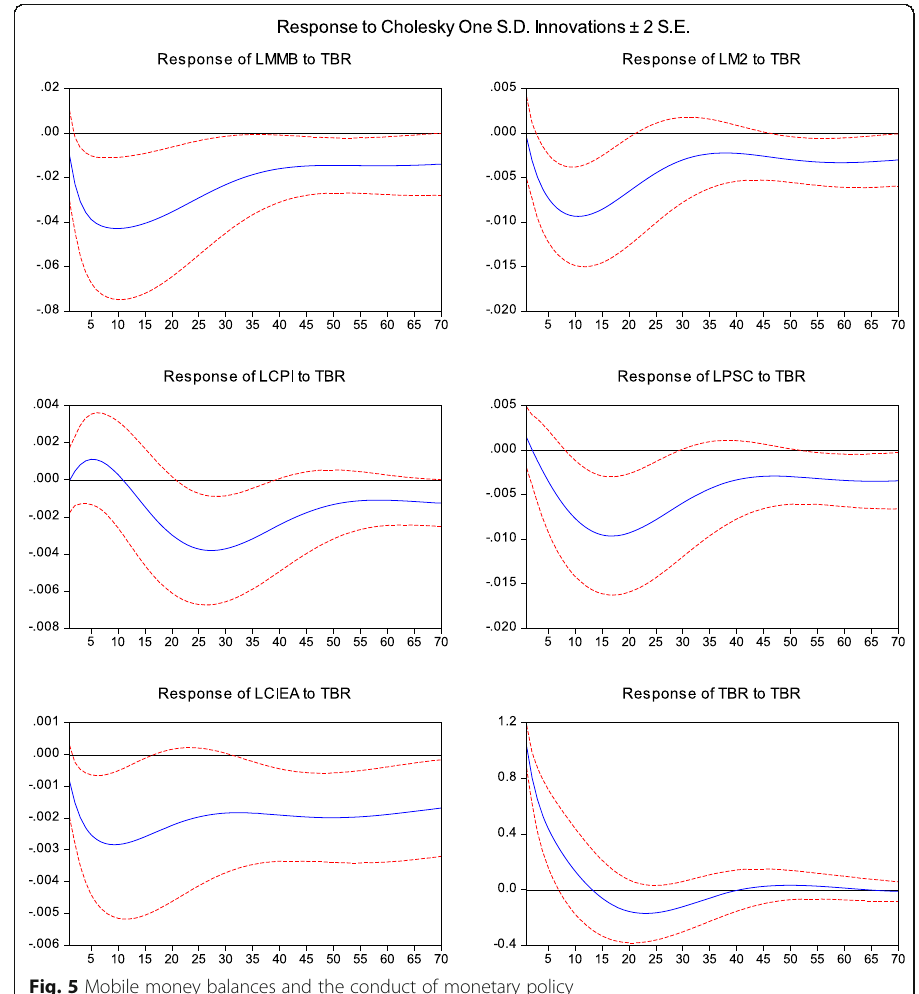
Fig. 5 Mobile money balances and the conduct of monetary